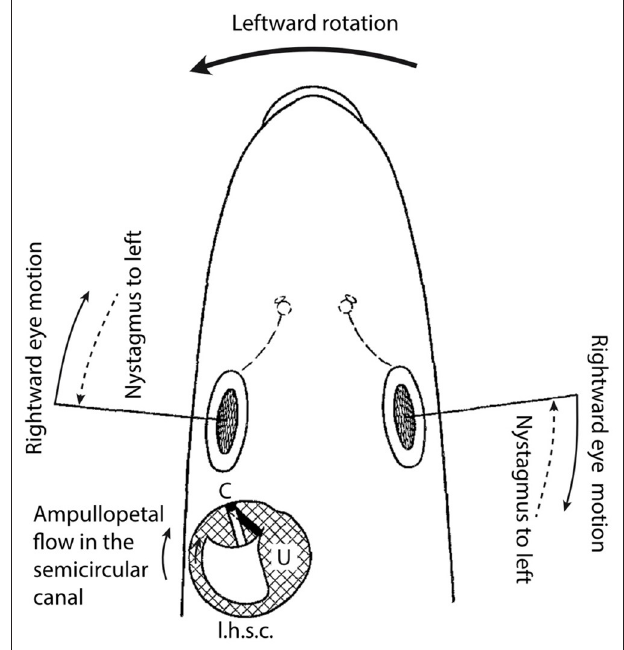
FIGURE 1 | Head of a pike viewed from dorsal with delineated left horizontal semicircular canal and utricle (schematic).